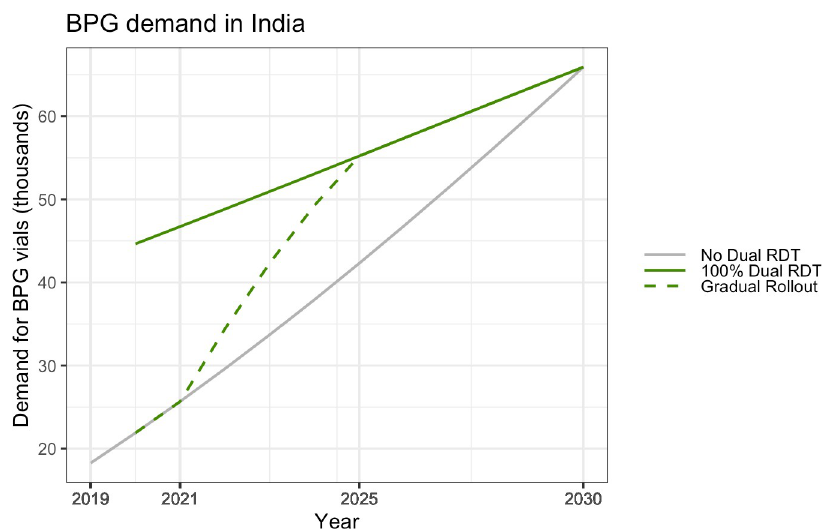
Fig 2. BPG demand for treatment of PW in a phased dual HIV/syphilis RDT roll-out scenario (India snapshot). Graph indicates the demand of 2.4 MU BPG vials in India under 3 different cases–no access to dual tests, access to dual tests available to all PW, access to dual tests increases gradually from 2021 to